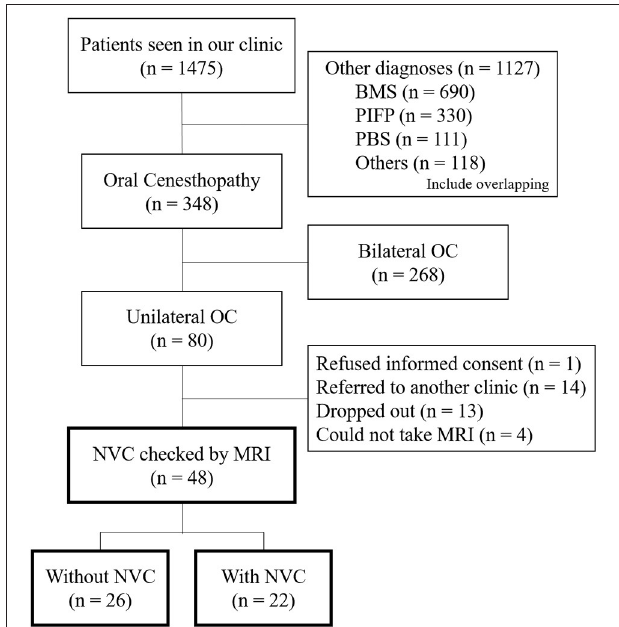
FIGURE 1 | A flowchart of the patients’ selection. Flowchart showing the selection of the patients having predominantly unilateral oral cenesthopathy for inclusion in the present study. OC, oral cenesthopathy; MRI, magnetic resonance imaging; NVC, neurovascular contact; BMS, burning mouth syndrome; PIFP, persistent idiopathic facial pain; PBS, phantom bite